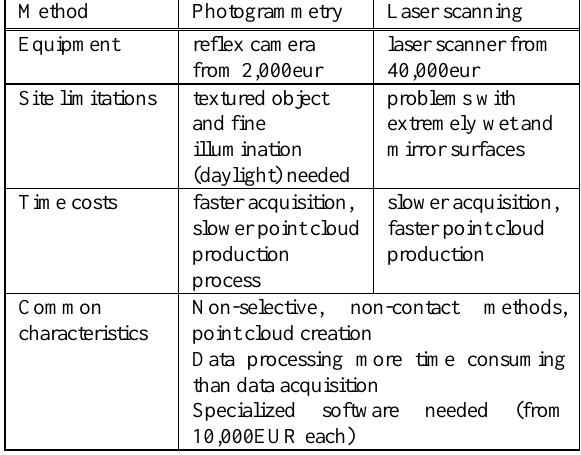
Table 2. General comparison of photogrammetry and laser